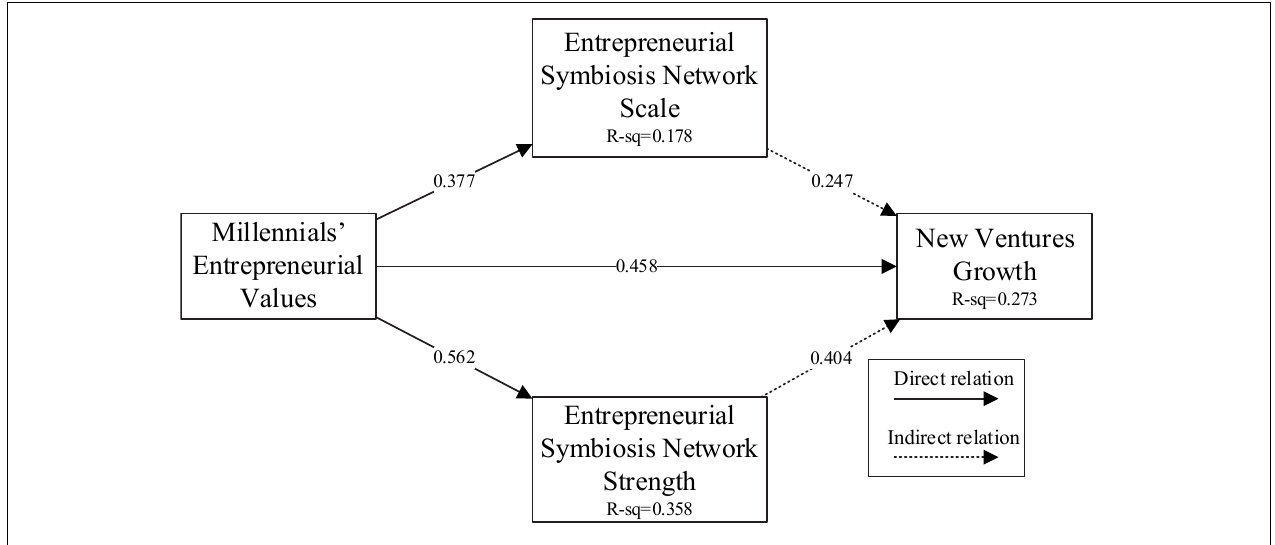
FIGURE 2 | Regression results for hypotheses